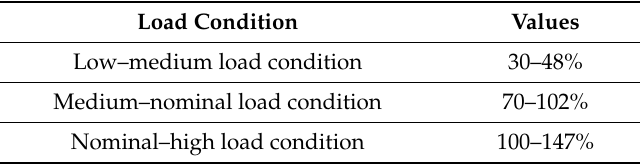
Table A3. Random variation